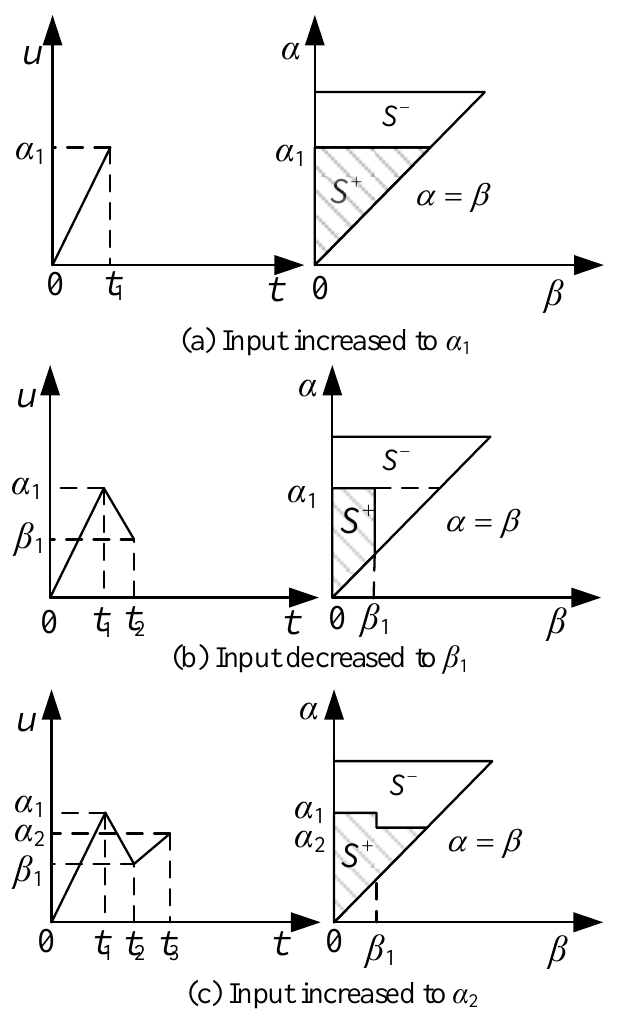
Figure 9. Geometric interpretation of the Preisach model.